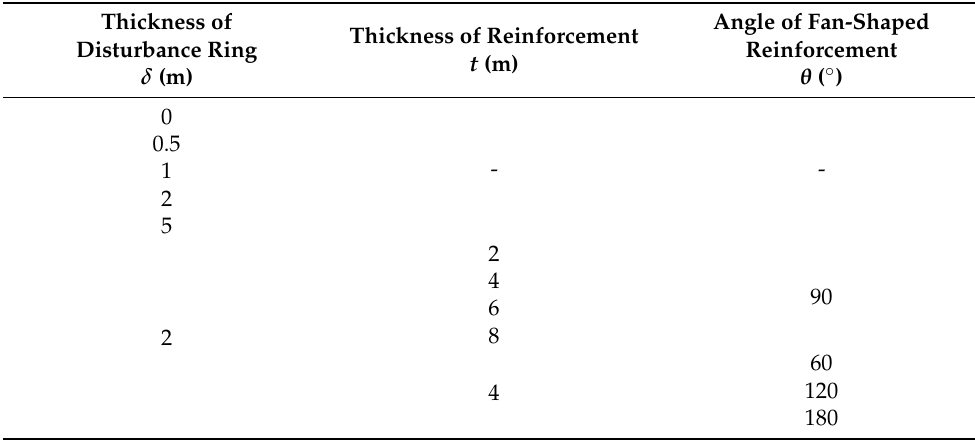
Table 2. Numerical simulation analysis